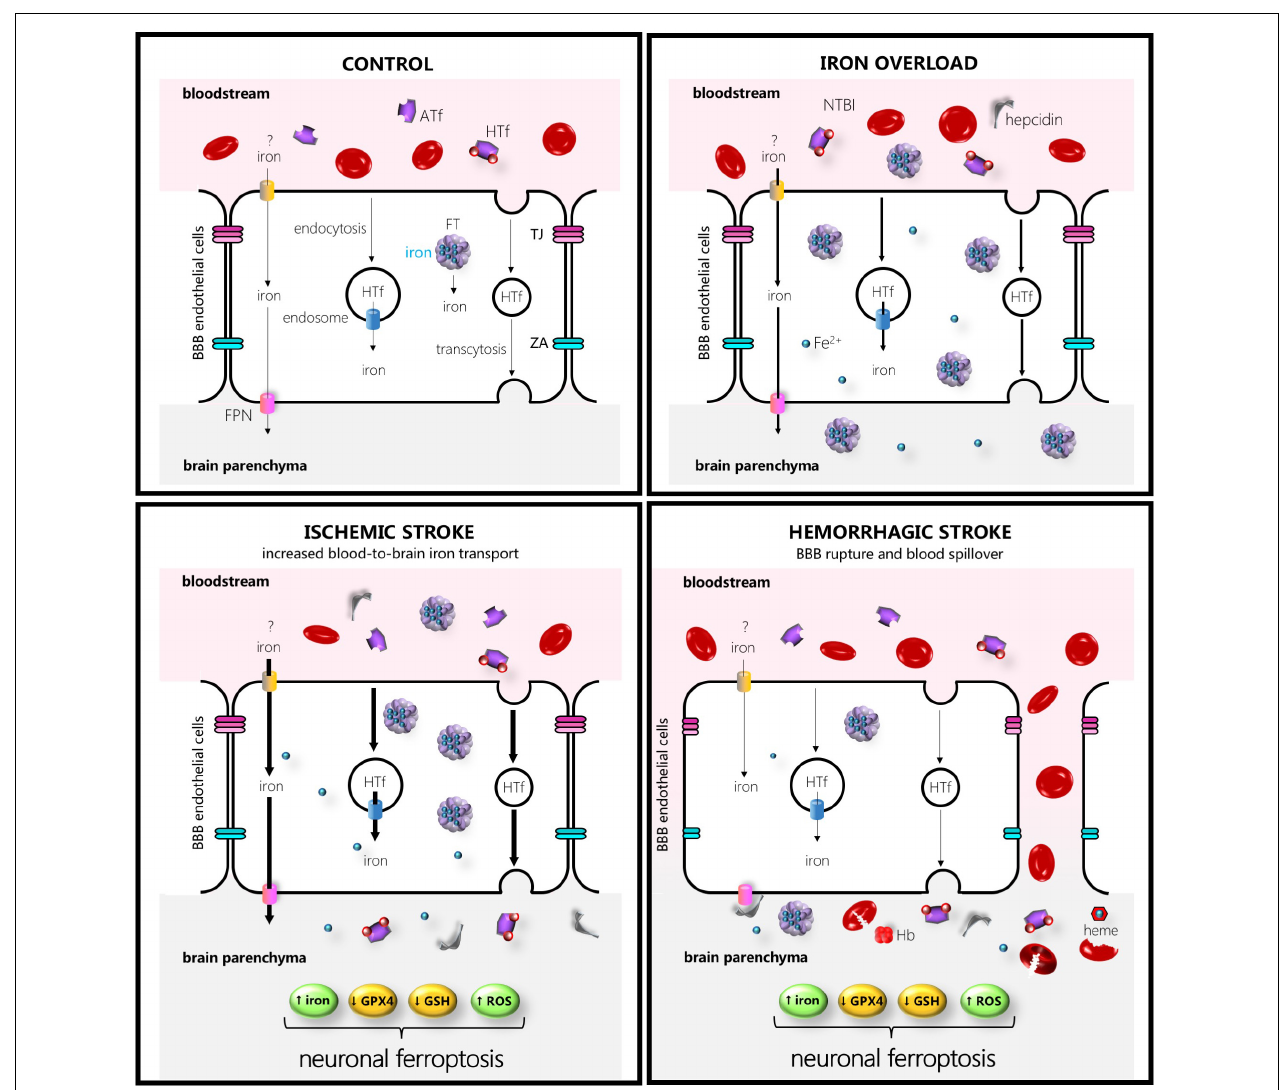
FIGURE 1 | Schematic drawing of some of the main players in iron transport to the brain in control (left hand upper side), iron overload (right-hand upper side), ischemic stroke (left-hand lower side), or intracerebral hemorrhage (right-hand lower side). The thicker the arrows the more increased the transport. Abbreviations: ATf, apotransferrin; FPN, ferroportin; HTf, holotransferrin; FT, ferritin, GPX4, glutathione peroxidase 4; GSH, glutathione; Hb, hemoglobin; NTBI, non-transferrin-bound iron; ROS, reactive oxygen species; TJ, tight junction; ZA, zonula